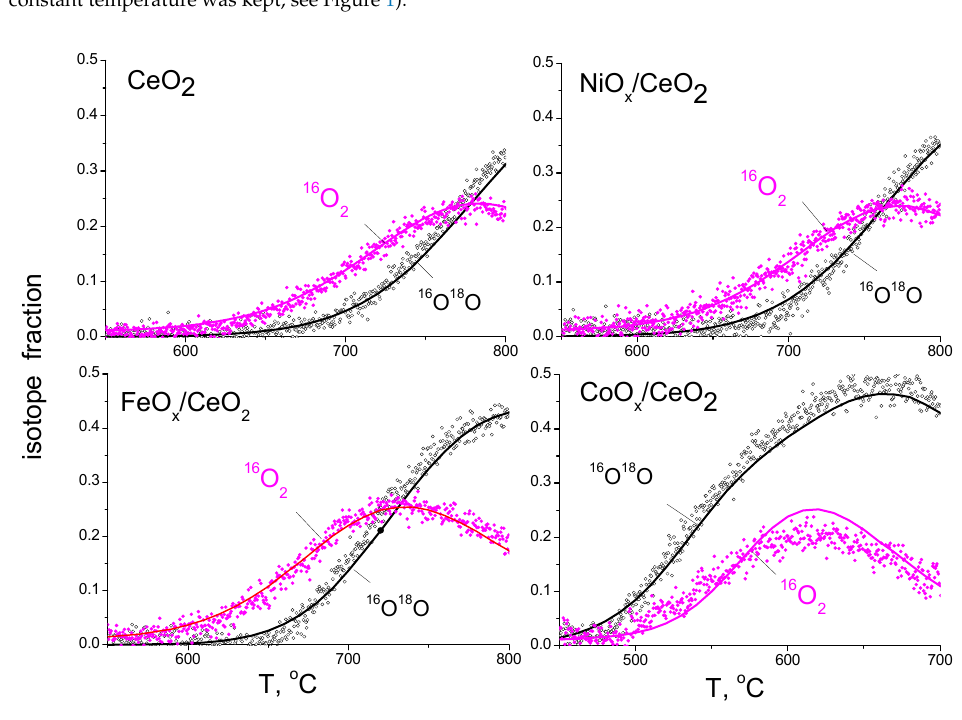
Figure 2. Change of 16 O 2 and 16 O 18 O fractions in O 2 during TPIE in different samples. Me concentration—0.86–0.91 wt.%. Points—experiment, lines—calculation.